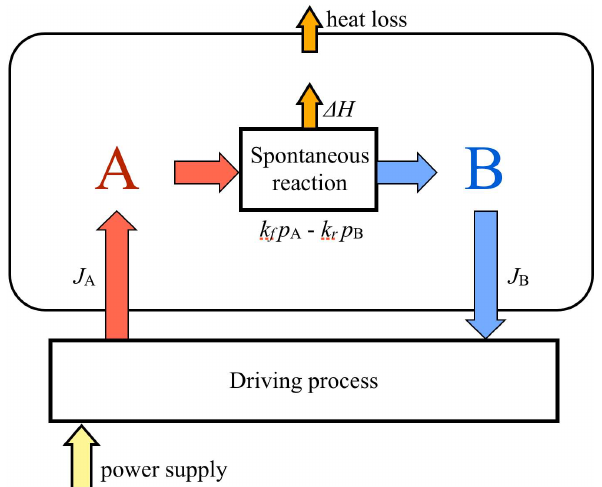
Fig. 1. A diagrammatic representation of our simple, illustrative model. A single “box” contains a mixture of two ideal gases, A and B, at standard conditions. A “driving process” uses a source of work to convert B into A at a rate J A = − J B , while a spontaneous chemi- cal reaction converts A into B at a net rate k f p A − k r p B . In steady state the rates of consumption and production of the two species by the two processes will balance. Both the driving process and the chemical reaction may release (as shown) or absorb heat.